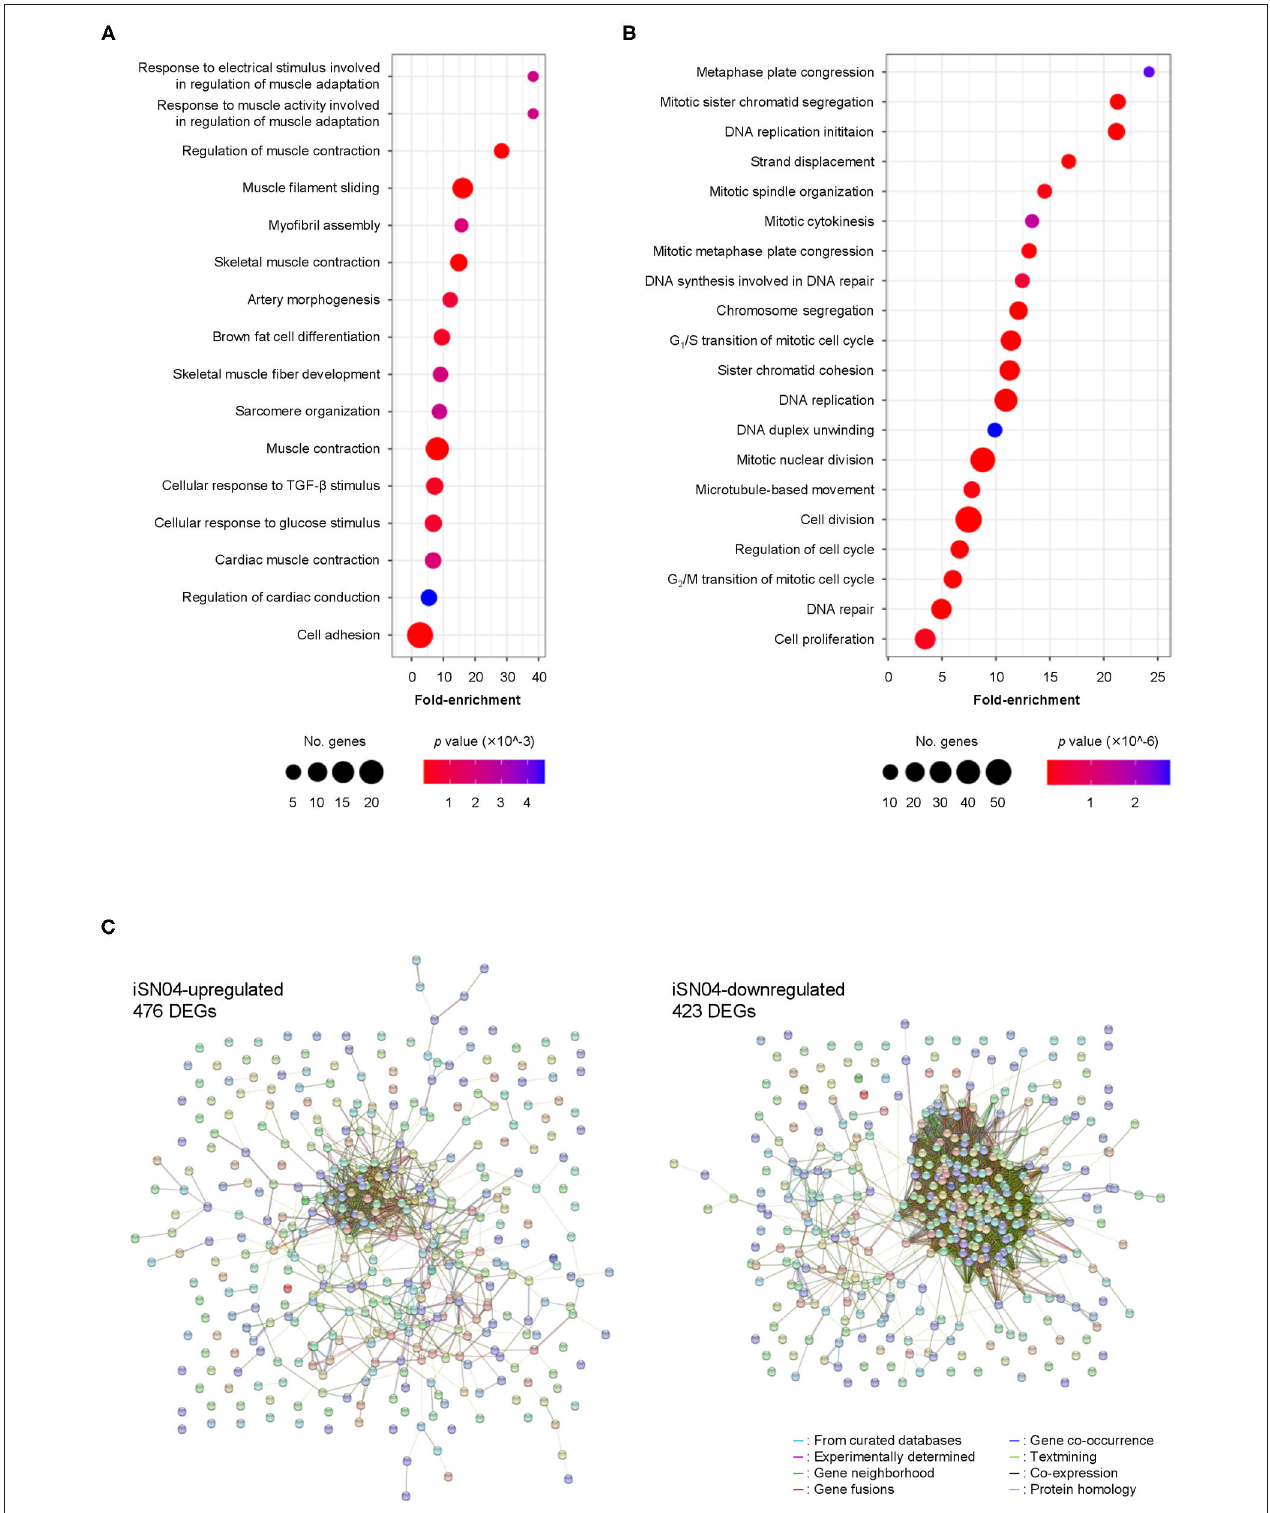
FIGURE 2 | Profile of iSN04-dependent gene expression. (A) Scattered plot of the 476 iSN04-upregulated DEGs significantly ( p < 5.0 × 10 − 3 ) enriched in GO terms. (B) Scattered plot of the 423 iSN04-downregulated DEGs significantly ( p < 5.0 × 10 − 6 ) enriched in GO terms. (C) Functional and physiological networks within the 476 iSN04-upregulated DEGs (left panel) and the 423 iSN04-downregulated DEGs (right panel) visualized via STRING analysis.